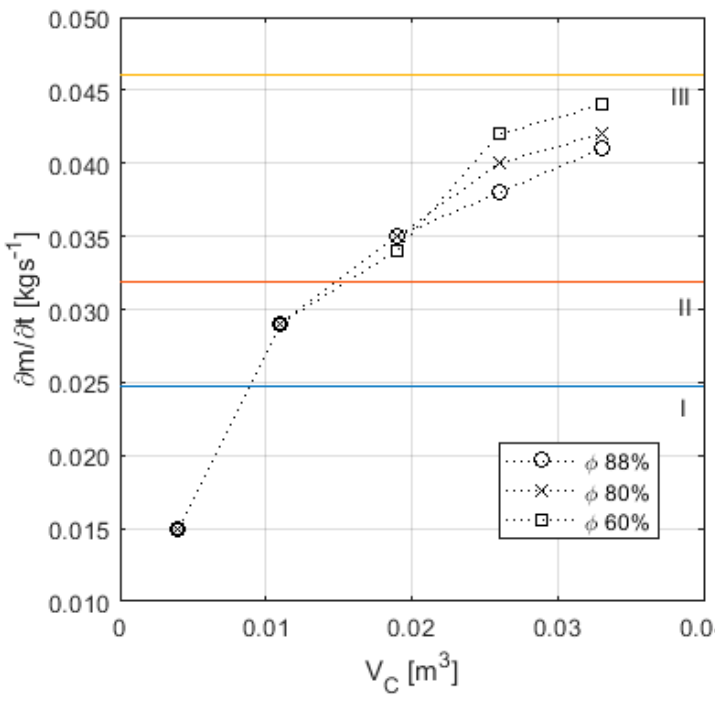
Figure 6. Relation of volume of product to required refrigerant flow.